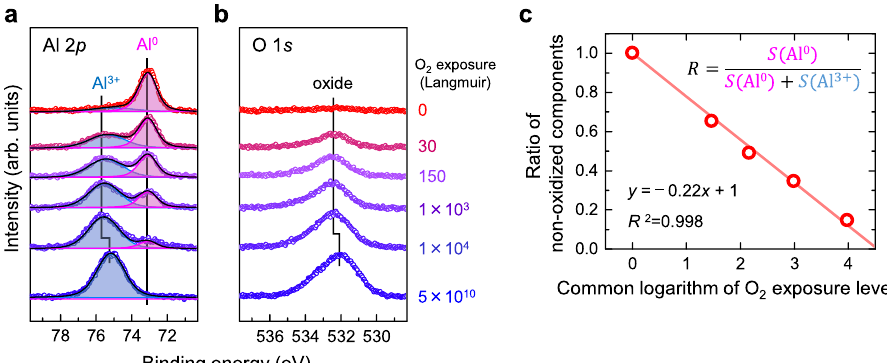
Fig. 2 Oxidative behaviors in the Al 2 p and O 1 s XPS spectra for Al 13 on the HB-HBC substrate. a , b XPS spectra around a Al 2 p and ( b ) O 1 s . With increasing O 2 exposure (from top red to bottom blue), the intensity of the zerovalent component (Al 0 ) decreases, while those of the oxidized component (Al 3 + ) and the O 1 s component increase accordingly. c The oxidative reactivity is evaluated by the slope of the dependence against the logarithmic O 2 exposure amount from 0 L to 1 × 10 4 L. At the highest exposure of 5 × 10 10 L, the Al 2 p peak shifts to a lower BE, likely due to a structural change relevant to the phase transition of aluminum oxide (see the main text for further details).